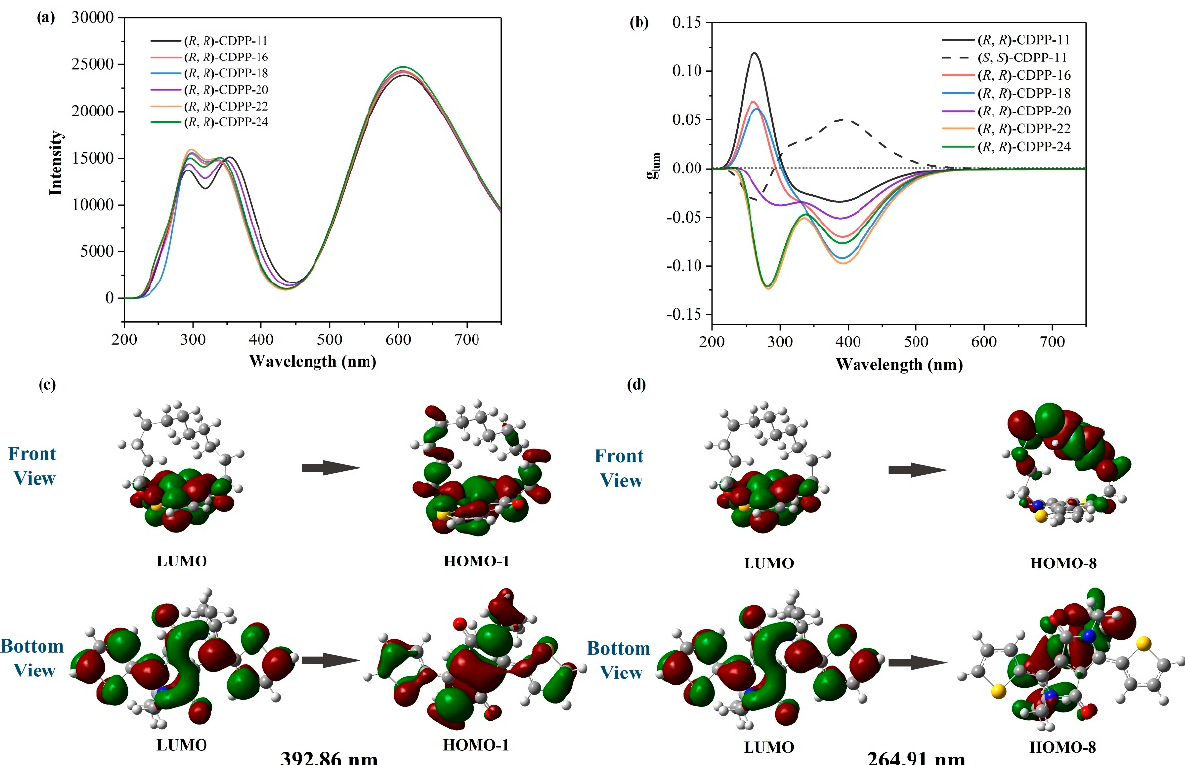
Figure 4. ( a ) calculated emission spectra of ( R , R )-CDPP molecules; ( b ) calculated g lum (after Gauss- ian broadening) of ( R , R )-CDPP molecules and ( S , S )-CDPP − 11; ( c ) the contour surfaces of FMOs involved in the emission of ( R , R )-CDPP − 11, corresponding to the g lum peak at around 392 nm; and ( d ) the contour surfaces of FMOs involved in the emission peak of ( R , R )-CDPP − 11, corresponding to the g lum peak at 265 nm.